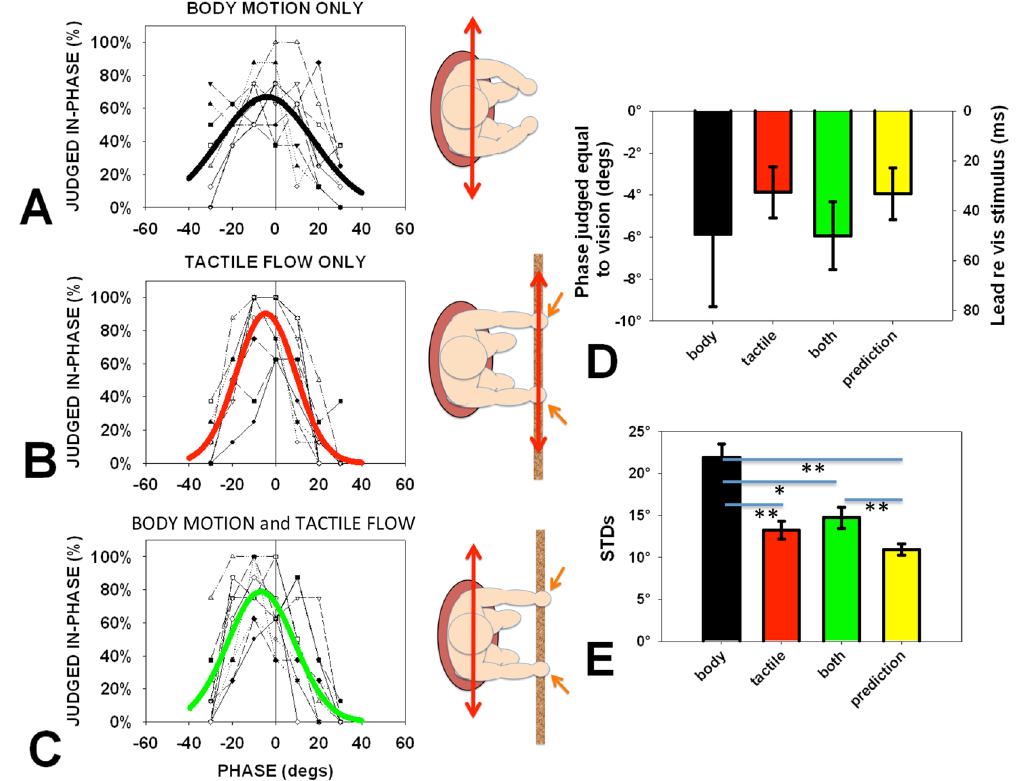
Figure 1. Frequency at which participants chose “same phase” plotted as a function of the phase difference between the visual stimulus and either the body motion only ( A ), tactile flow only ( B ), or combined conditions ( C ). Each participant’s performance is shown, with best-fit Gaussians fitted to the means plotted as a thick line through each data set. The experimental conditions are shown as insets. For the body motion only condition the observer sat on a moving swing in darkness. For the tactile flow only condition the observer held their fingertips lightly over a moving surface. For the combined condition observers oscillated on the moving swing with their fingertips lightly touching an earth-stationary surface. The mean phase with equivalent time delay ( D ) and standard deviation (STD) ( E ) of the fits to each participant’s data is shown along with the prediction of the maximum likelihood estimation (MLE) model (yellow bars). Error bars are standard errors. Horizontal lines with asterisks indicate statistically significant differences. * p < 0.05, ** p < 0.01, *** p <